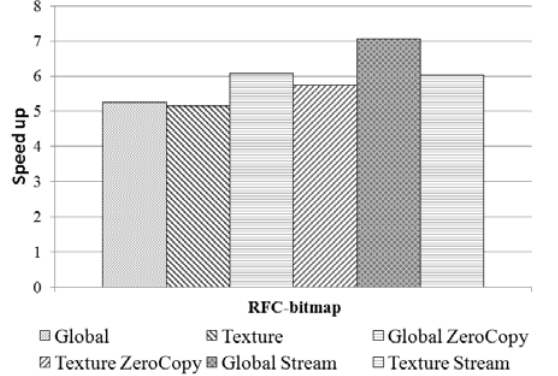
Fig. 11. Performance comparison between CPU-based and GPU-based BitMap-RFC classification algorithms with a variety of memory usage.